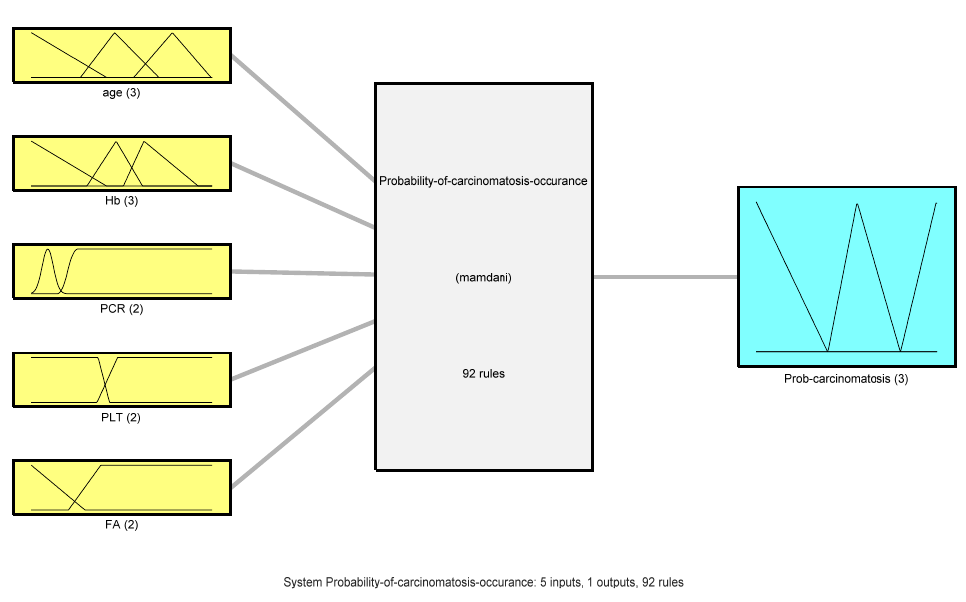
Figure 1. Fuzzy system for probability of carcinomatosis occurrence.